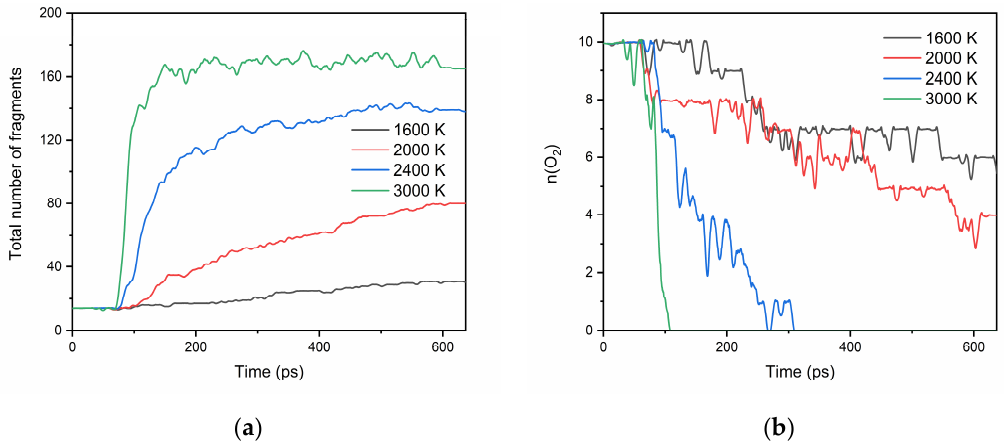
Figure 2. Changes of ( a ) the total number of fragments and ( b ) the number of oxygen molecules as a function of time at different simulation